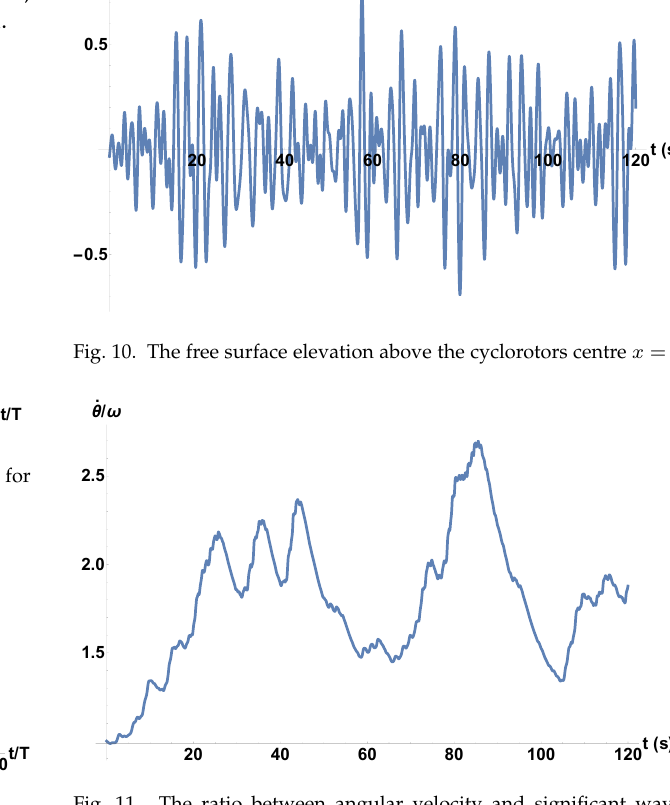
Fig. 11. The ratio between angular velocity and significant wave frequency 1 /T s for symmetric rotor in panchromatic waves.